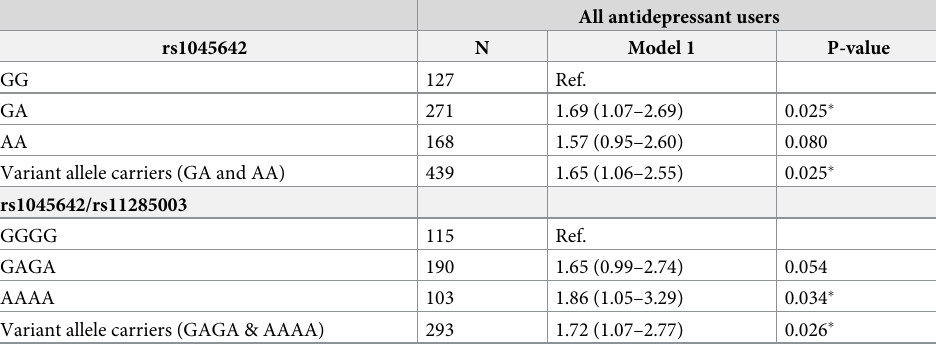
Data is presented in odds ratio and 95% confidence interval. N = number of participants per genotype. Model 1 was adjusted for age and gender. � statistically significant at p <